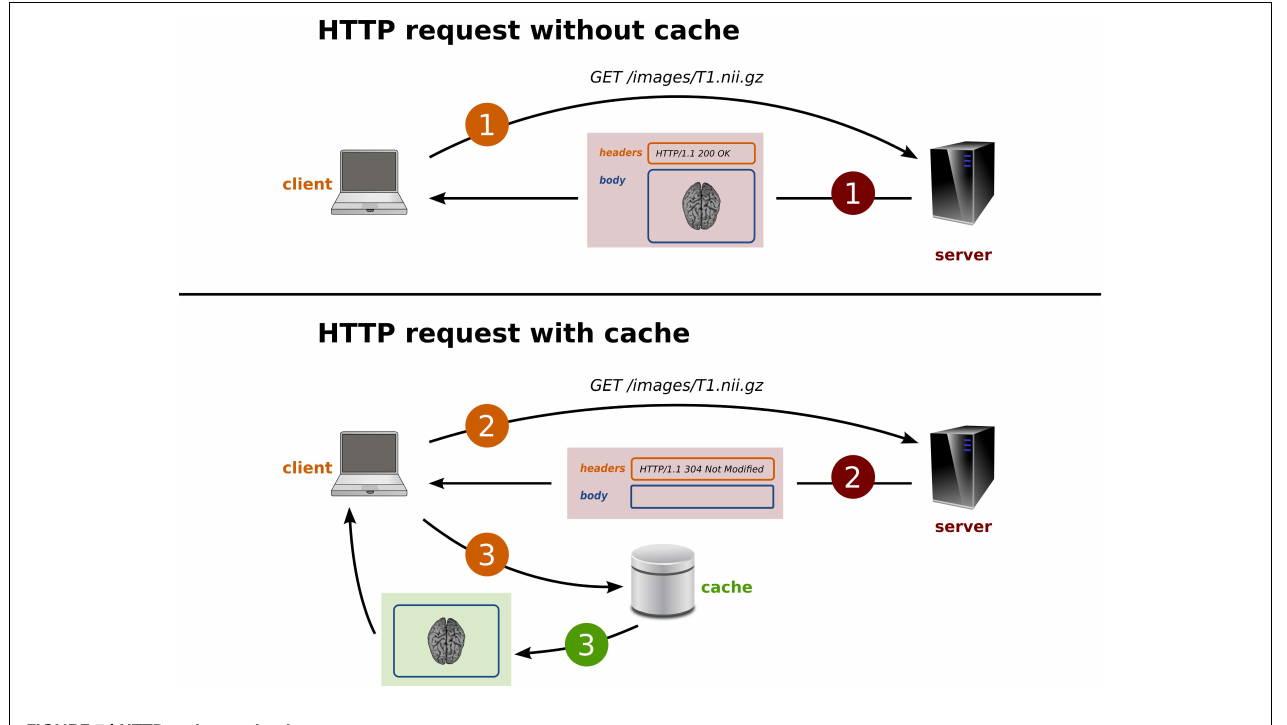
FIGURE 7 | HTTP cache mechanism.